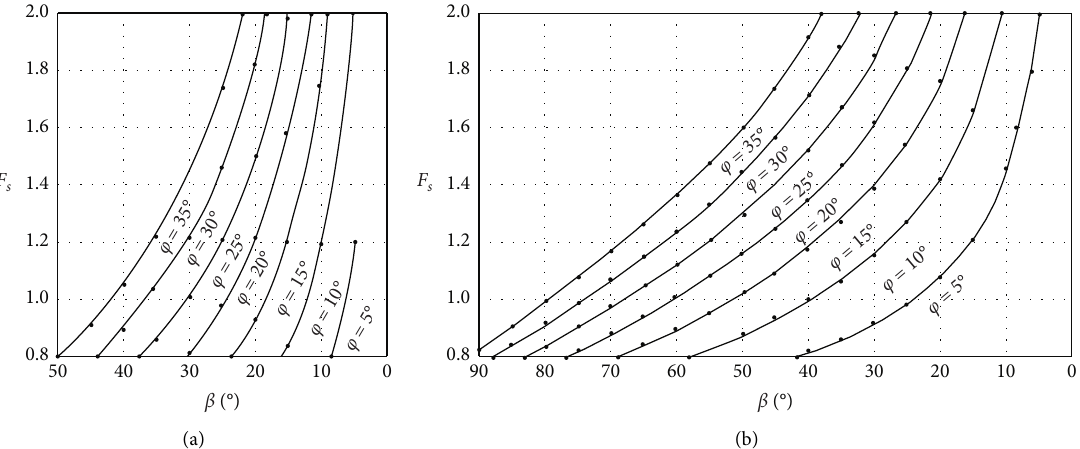
Figure 5: Factor of safety charts for homogenous slopes. (a) c / c H